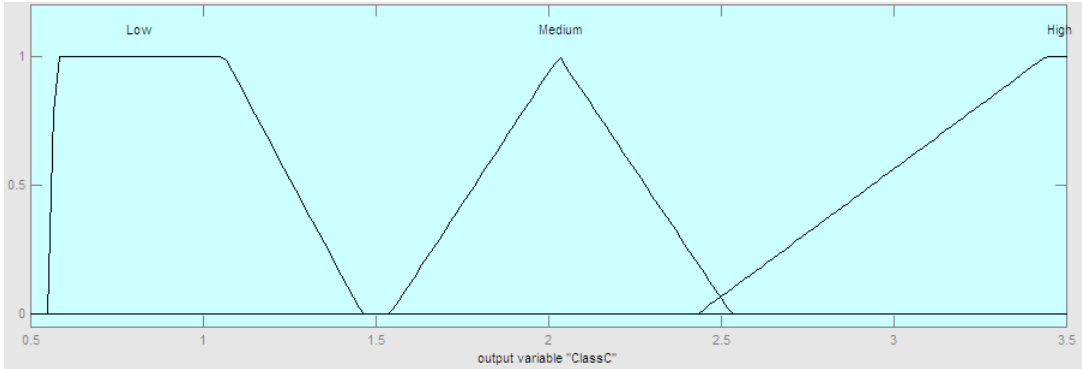
Figure 5. Membership functions of the Output, which is the Classification of Countries.